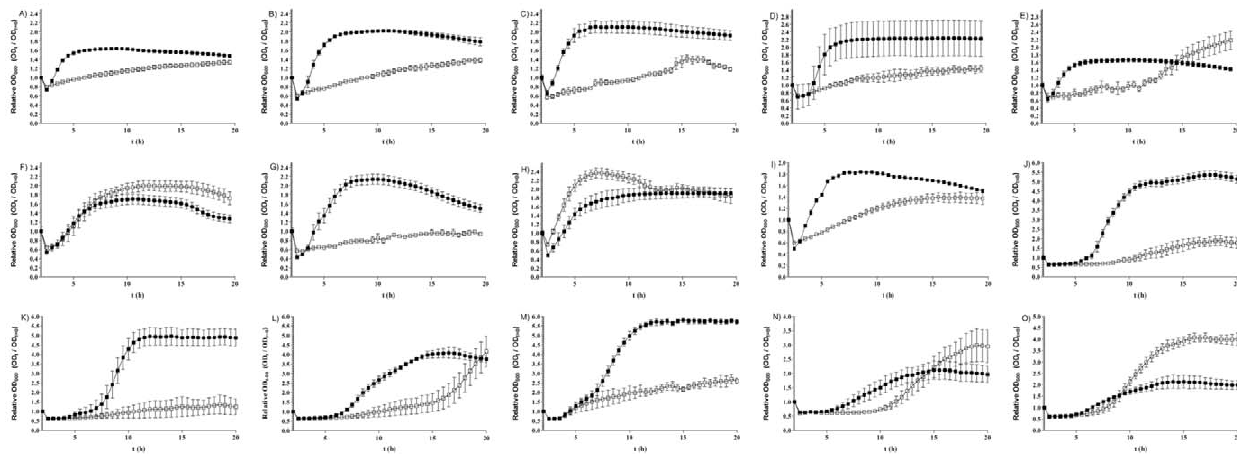
Figure 5. Cell growth from spores of 15 C.difficile isolates. Spores were heat treated at 60 u C for 25 min and then incubated with either BHIS alone ( % ) or BHIS supplemented with 0.1% (w/v) taurocholate ( & ). The change in OD 600 was measured over 24 h. A) 9001966; B) R12087; C)